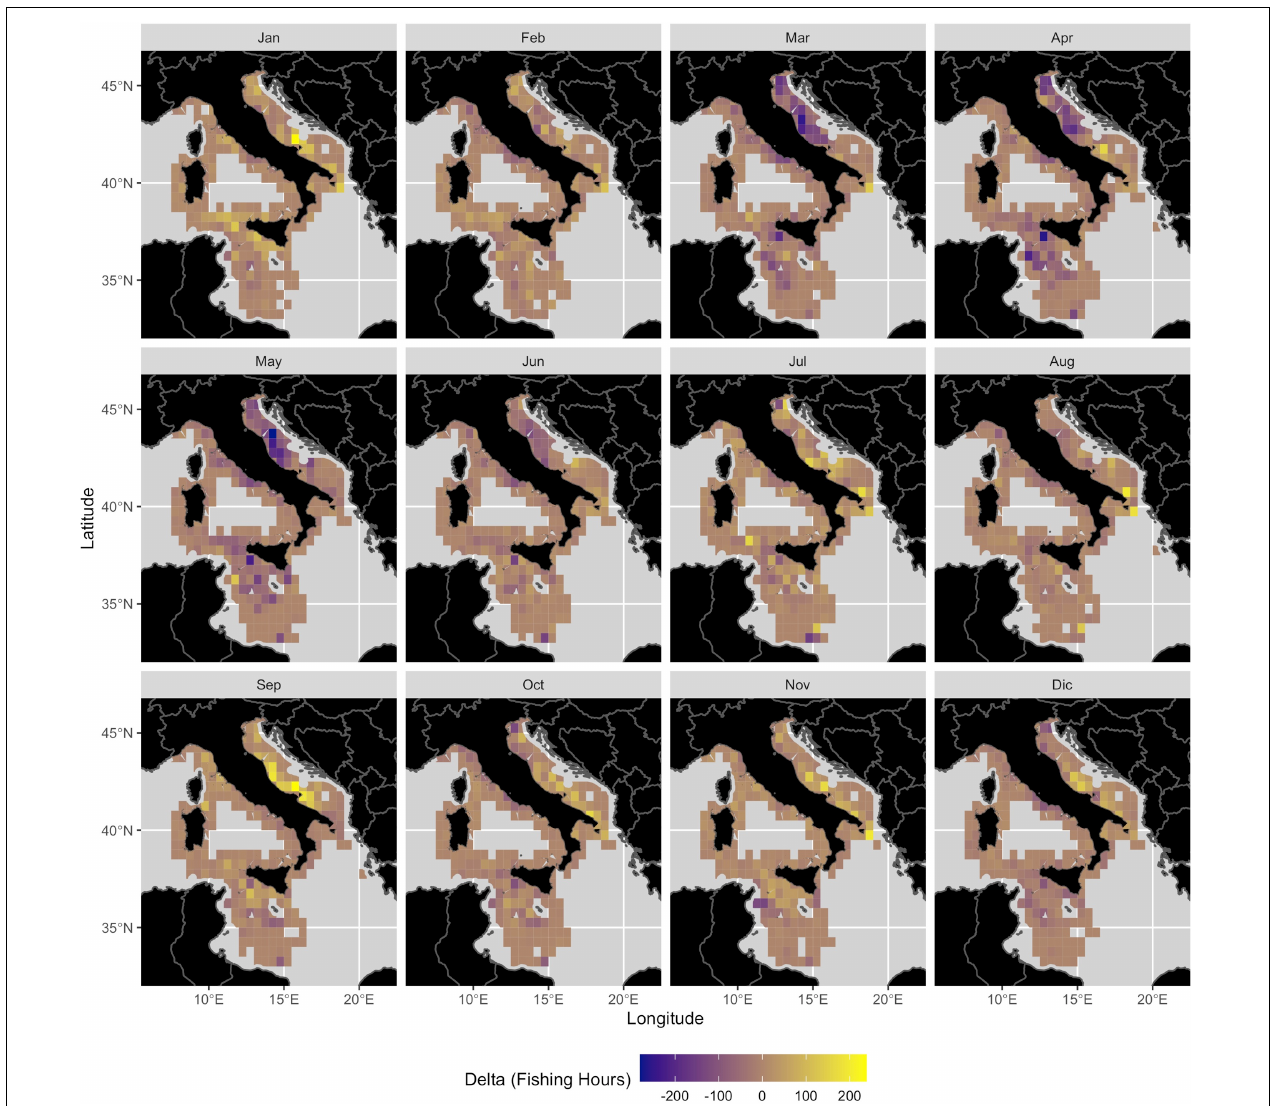
FIGURE 6 | Pattern of changes (difference in percentage between the value of Fishing Hours in 2020 and the mean values during the years 2015–2019) over the-30 × 30 nautical miles grid established by the GFCM